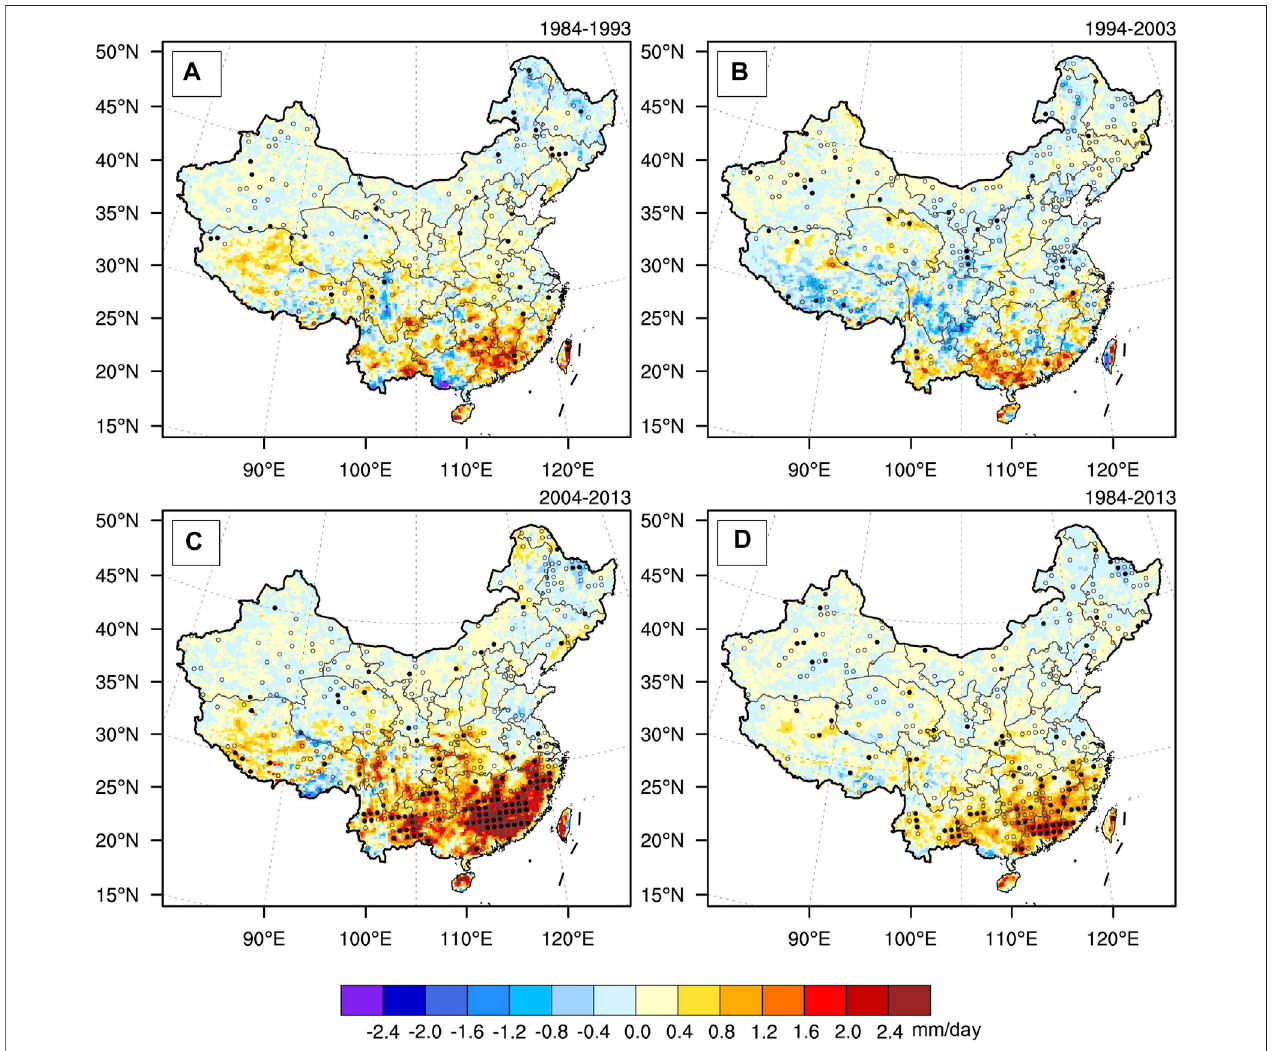
FIGURE 5 | The ensemble mean results of realistic LUCC-induced changes in convective afternoon rainfall (CAR; units: mm/day) in the post- fl ood season (POF; July-August-September) during multiple periods over China: (A) 1984 – 1993, (B) 1994 – 2003, (C) 2004 – 2013, and (D) 1984 – 2013. The solid (hollow) black dots in the fi gures denote a greater than “ moderate ” ( “ weak ” ) degree of consistency among the results of the ensemble members.